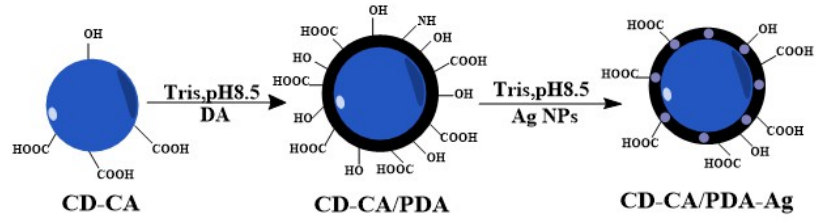
Figure 1. Preparation steps of CD-CA/PDA-xAg.